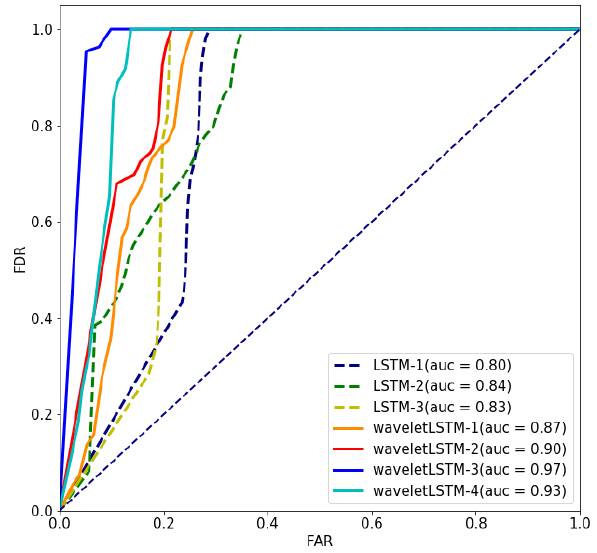
Figure 11. Effects of depth on detection performance with our WaveletLSTM and the compared LSTM model.